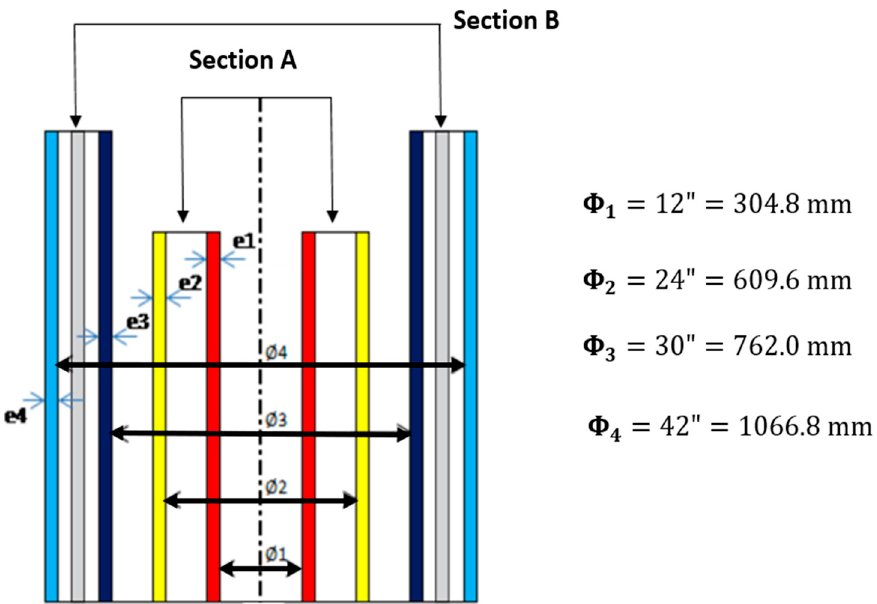
Figure 7. Longitudinal section of the cylindrical surface of the vertical boiler, showing dimensions of diameters.